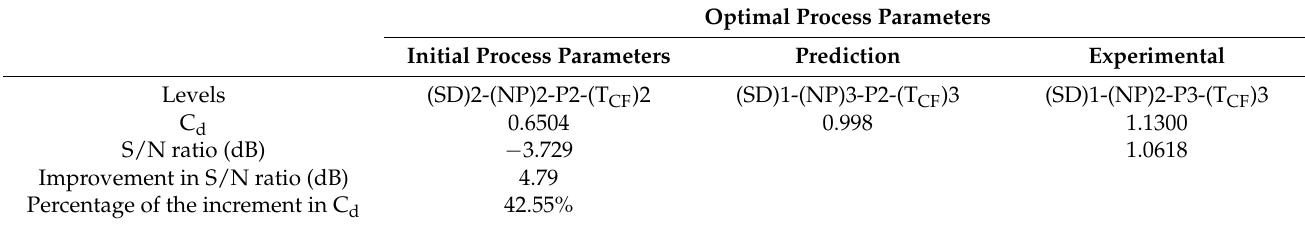
Table 6. Confirmation test results for C d